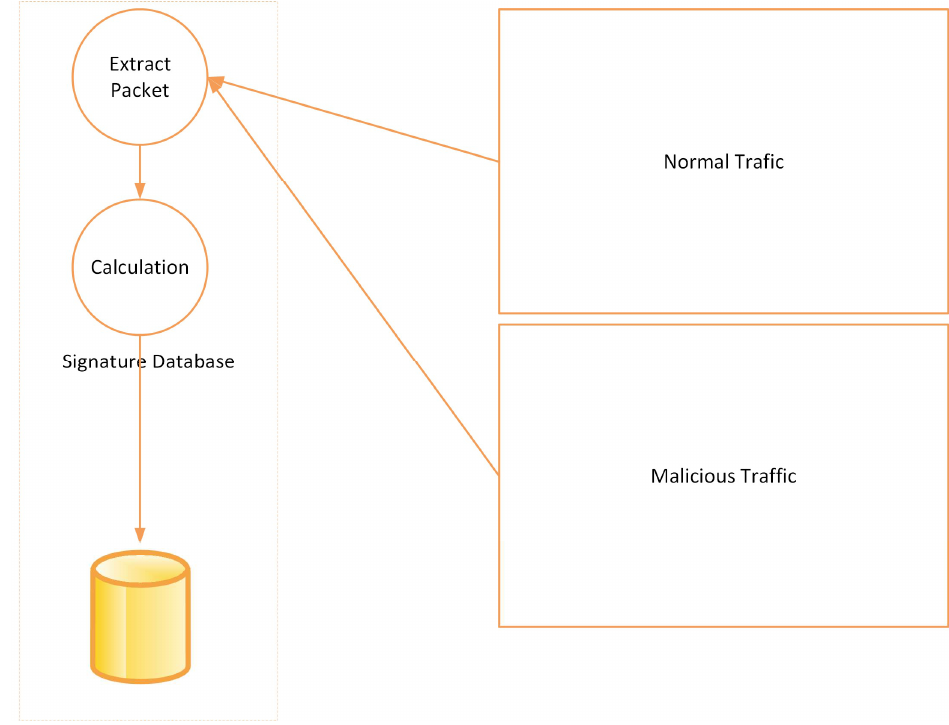
Figure 2. Storing the labels of classified packets in a database.